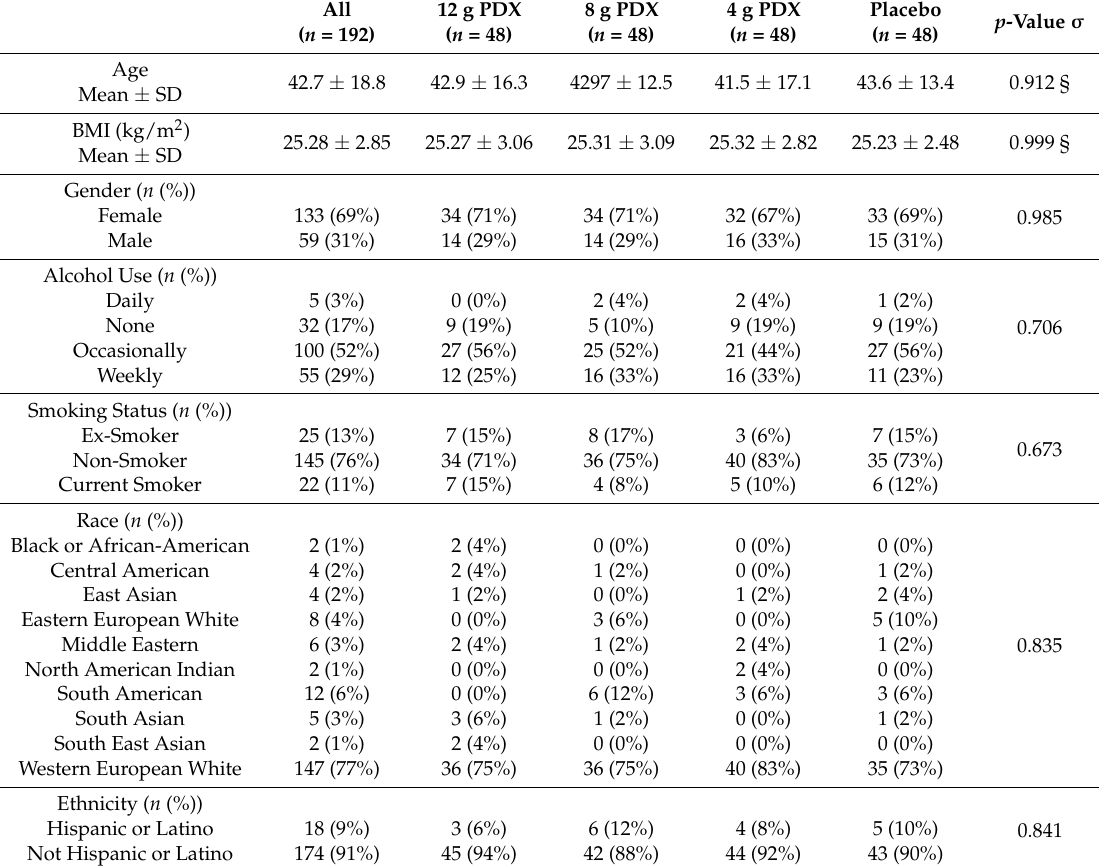
Table 1. Demographics for participants in the intention-to-treat population ( n =